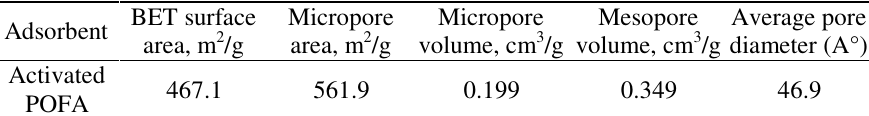
Table 1. Physical properties of activated palm ash BET surface Adsorbent area, m 2 /g